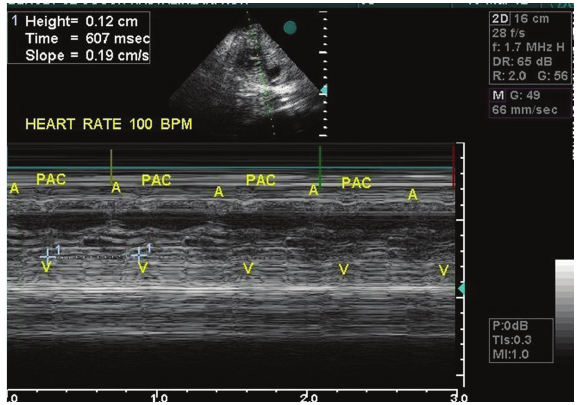
Figure 1: M-mode fetal echocardiogram showing bigeminal PACs associated with a fetal ventricular rate of 80–100bpm (the A-PAC interval is markedly shortened).